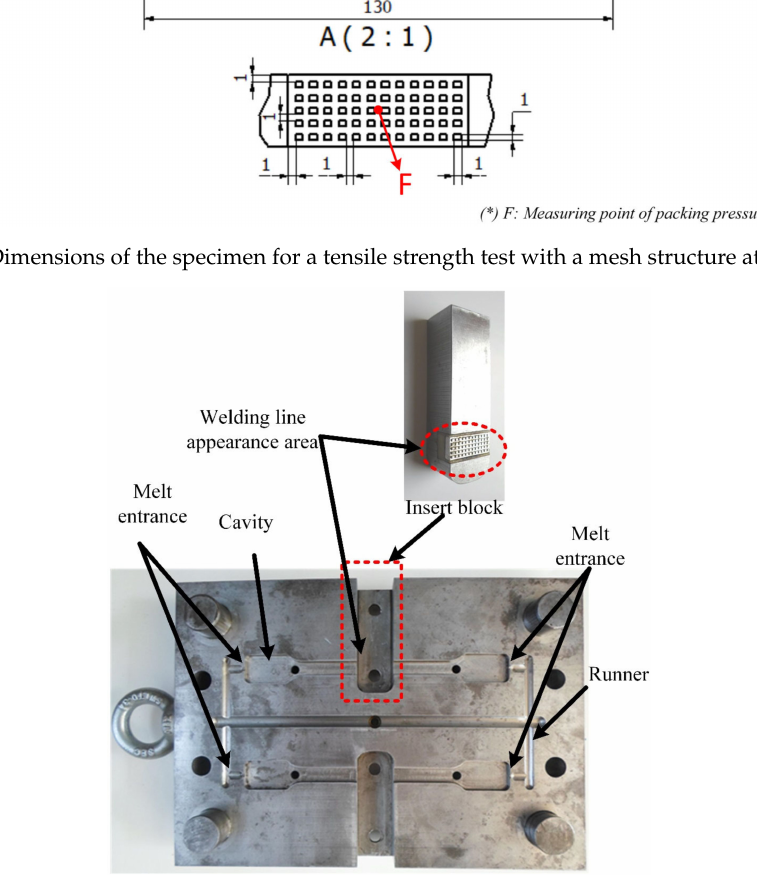
Figure 7. Cavity of the specimen used for the tensile strength